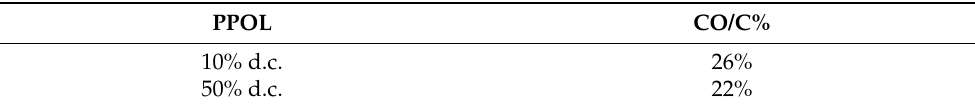
Table 4. Ratio CO/C for different d.c. conditions. The ratio is calculated for the PPOLs obtained at 10% d.c. and at 50%